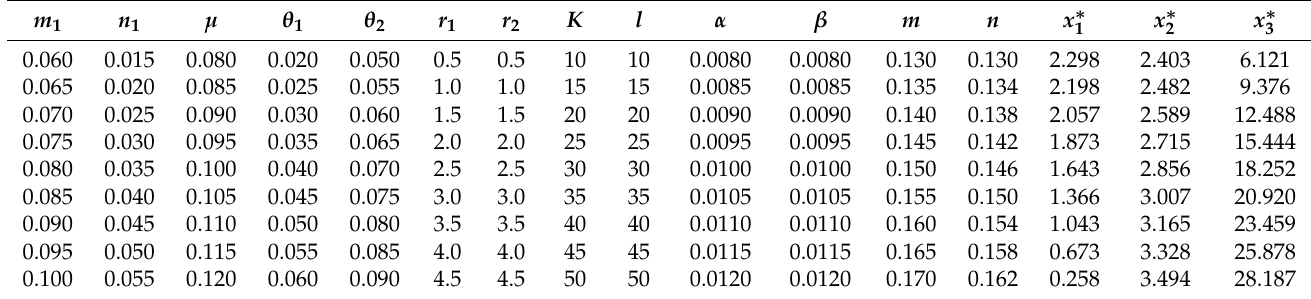
Table 2. Variation of the balance points according to the network parameters.